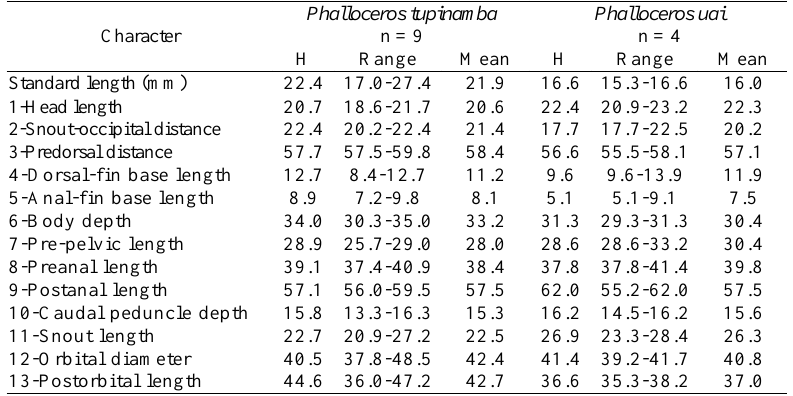
Table 8. Descriptive morphometrics of male specimens of Phalloceros tupinamba and P . uai . Measurements 1-10 are percents of standard length and measurements 11-13 are percents of head length. H =